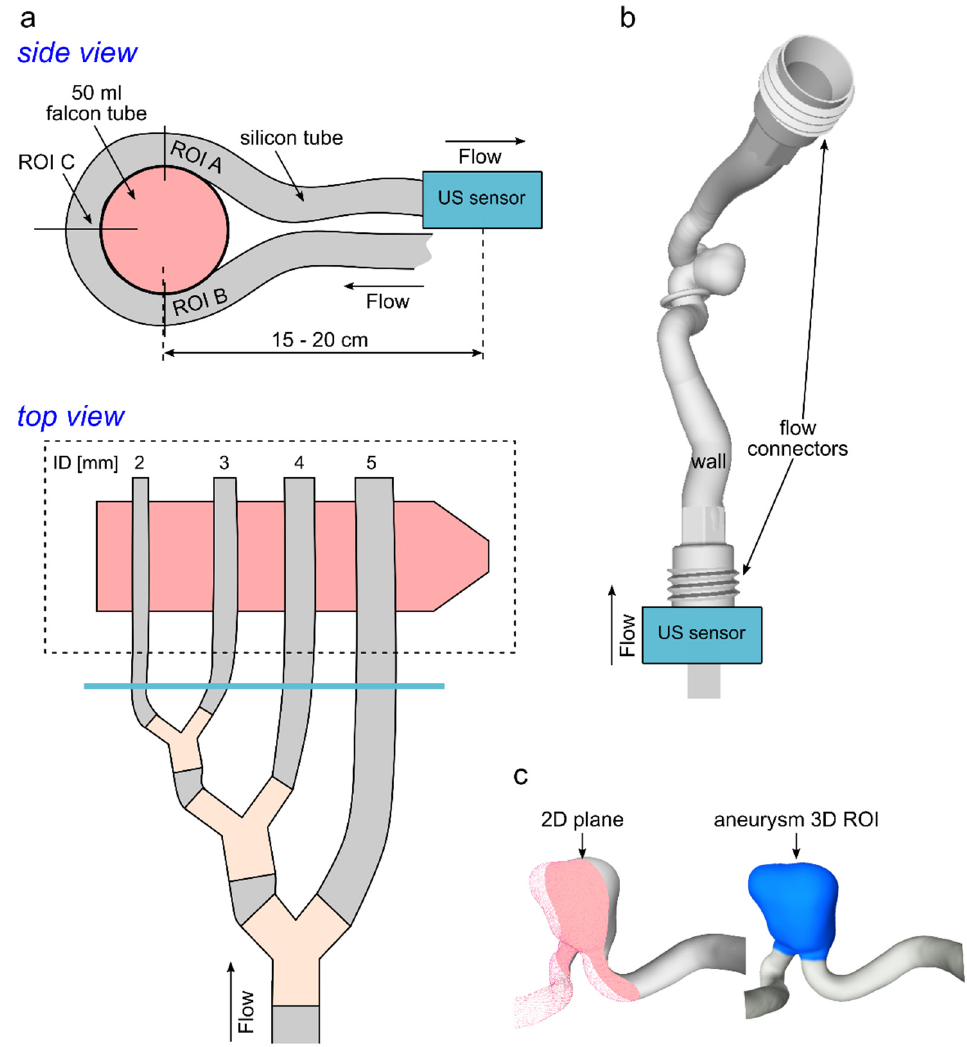
Figure 1. Schematic view of model 1 (( a ) silicone tubes) and model 2 (( b ) patient-derived aneurysm). ( a ) Silicone tubes were wound around a falcon tube ( a top) and connected sequentially to the pump ( a bottom). A US sensor was placed at the outflow of the tubes (blue line). The flow was analyzed at the plane’s ROI A-C. ( b ) Volume rendering of the patient-derived vascular model. A US sensor was placed at the inlet of the model. ( c ) The velocity field was visualized at the 2D evaluation plane ( c left) and calculated in the aneurysm 3D ROI ( c right).